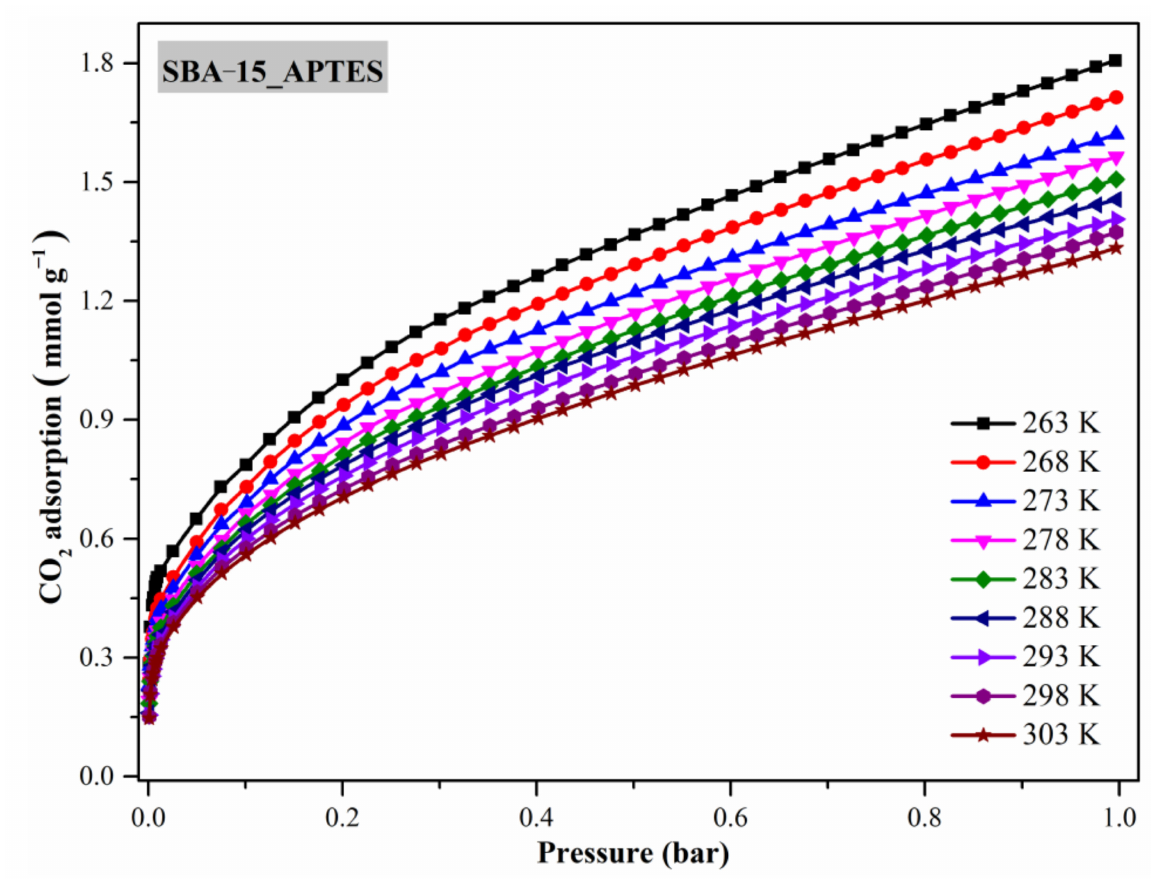
Figure 11. CO 2 isotherms of SBA-15 calcinated at 623 K and functionalized with (3-Aminopropyl)triethoxysilane (APTES). Table 3. Comparation of the CO 2 adsorbed between samples reported in this work and other studies. Adsorbent Functionalizing Agent